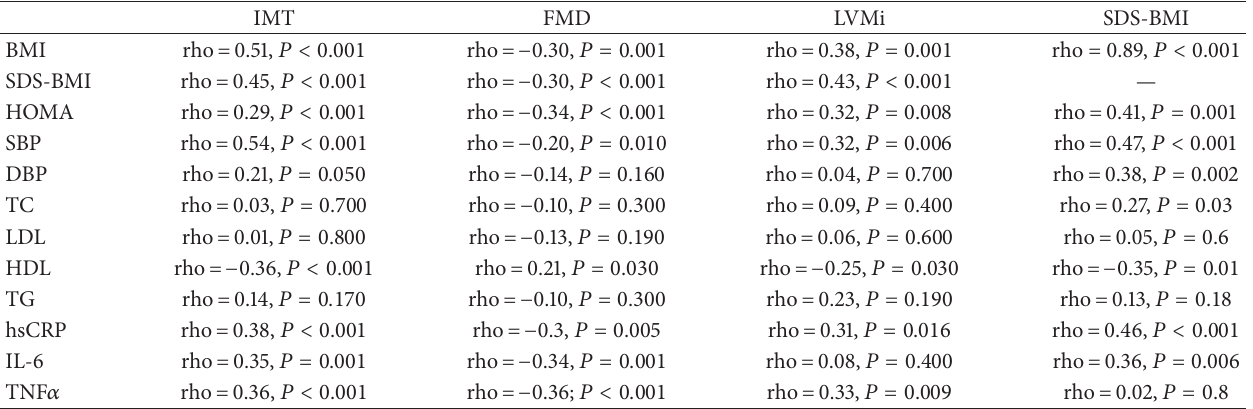
Table 5: Correlations (Spearman correlation coefficient—rho) between IMT, FMD, LVMi, SDS-BMI, and traditional cardiovascular risk factors and inflammatory markers in the study group.